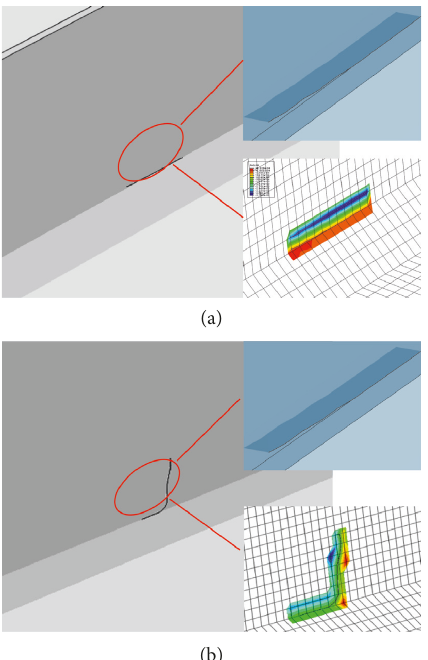
Figure 16: The morphology of crack propagation at the welding toe of U-rib. (a) Without residual stress field. (b) With residual stress field.